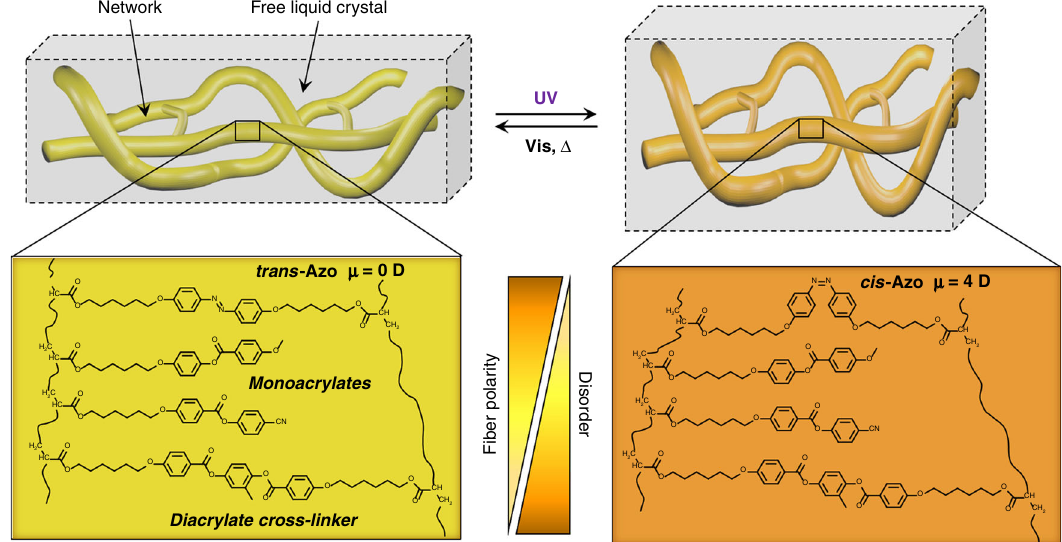
Fig. 1 Design and composition of mechanically adaptive polymers. The zoom shows the molecular components of the network. The network and the free fraction of liquid crystal phase separate. The photo-induced isomerization of the azobenzene induces disorder and increases the polarity of the fi bers, and therefore isomerization impacts the orientation (anchoring) of the free liquid crystal molecules, and their miscibility to the network